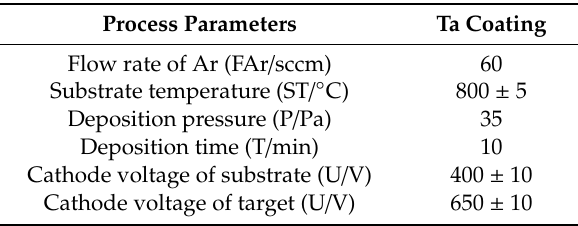
Figure 1. ( a ) SEM images of the 3Y-TZP ceramic, and ( b ) image with large magnification. Table 1. Preparation parameters of Ta coating. Table 1. Preparation parameters of Ta